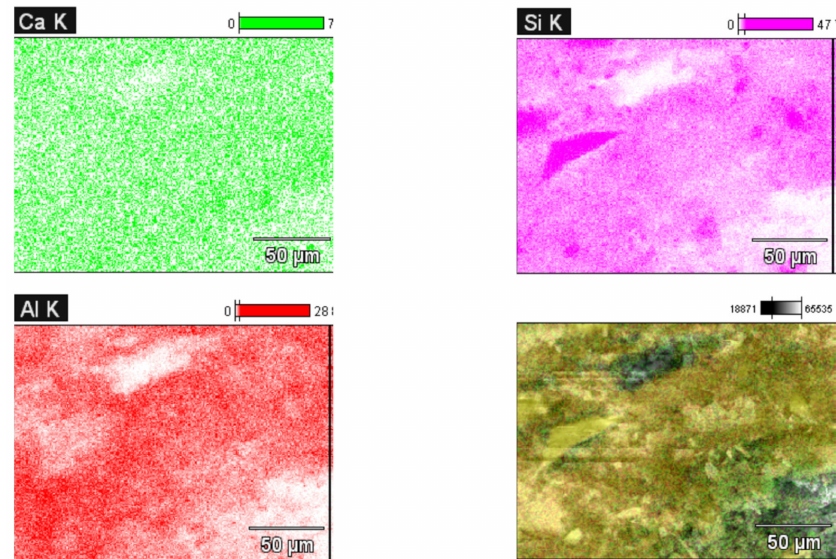
Figure 12. SEM-EDX mapping for a treated distance of 600 mm (D60), showing Ca, Si, Al and their overlapping mapping with the SEM image.